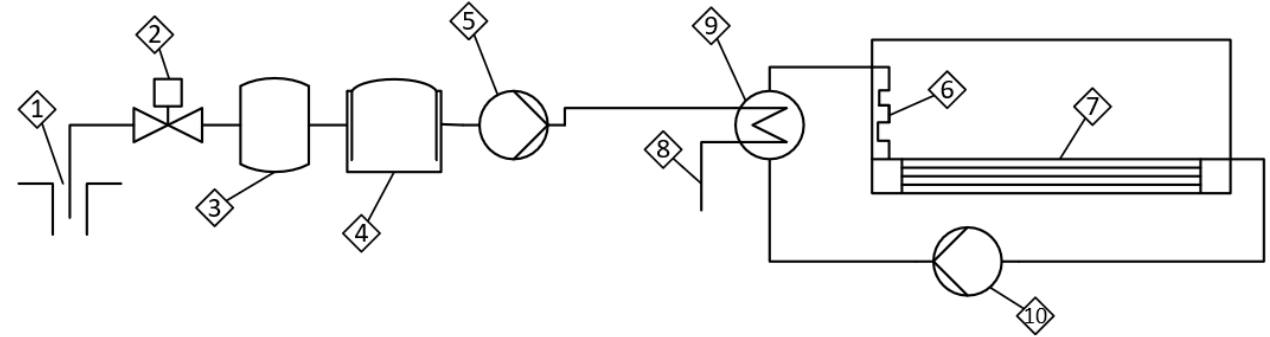
Figure 2. Functional scheme of a geothermal heat supply system for greenhouses with a surface heat exchanger: 1—a geothermal well, 2—an electric valve, 3—a sump, 4—a degasser, 5—a primary circuit pump, 6—a greenhouse tent heating system, 7—a system soil heating, 8—a wastewater sewer, 9—water–water heat exchanger, 10–a secondary circuit pump.